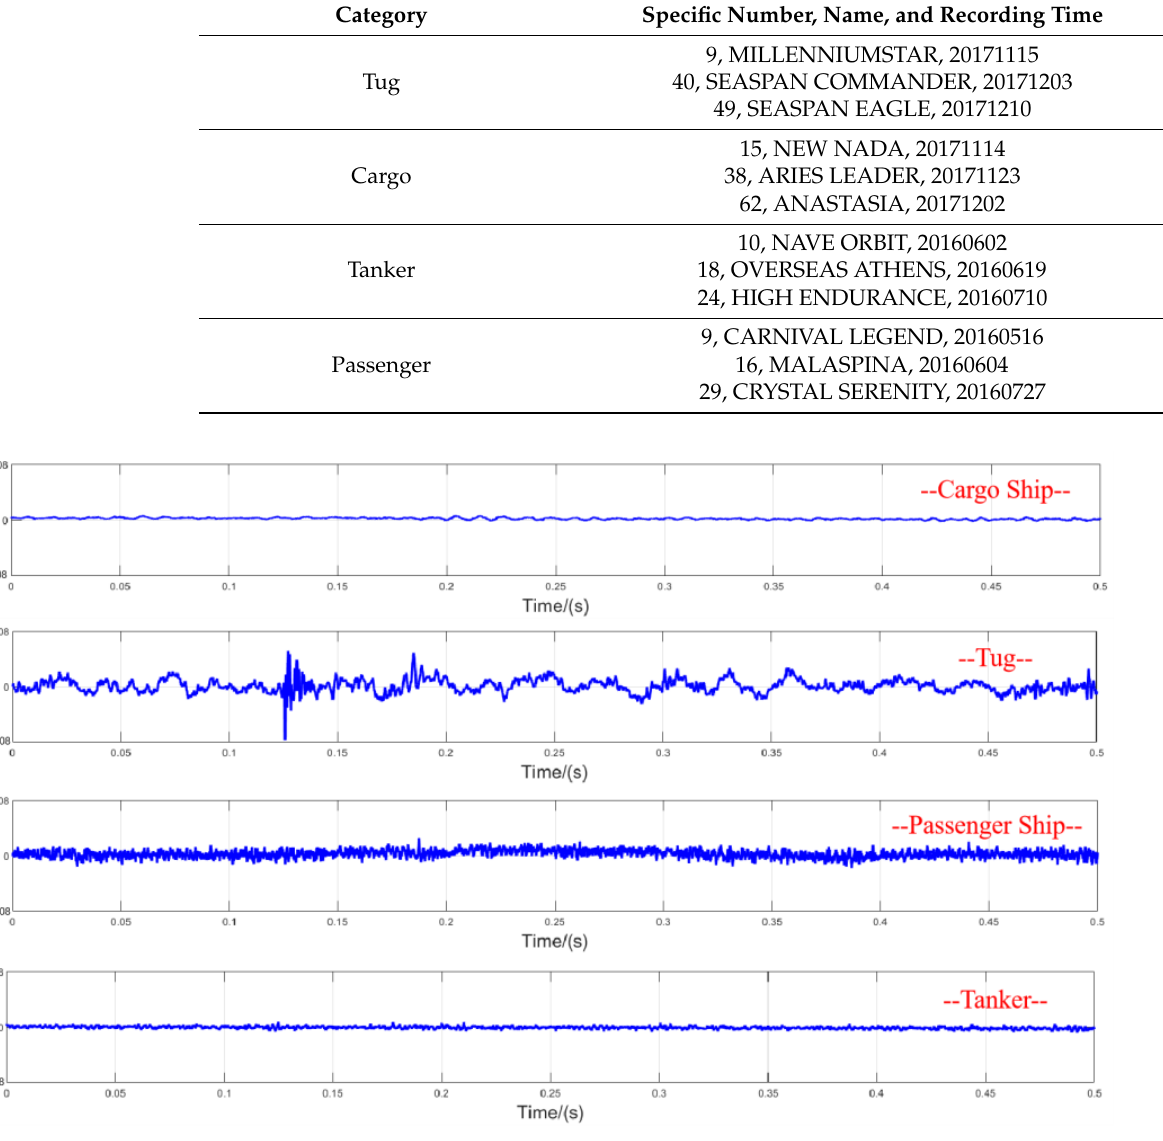
Table 1. The information of raw recordings of ships.